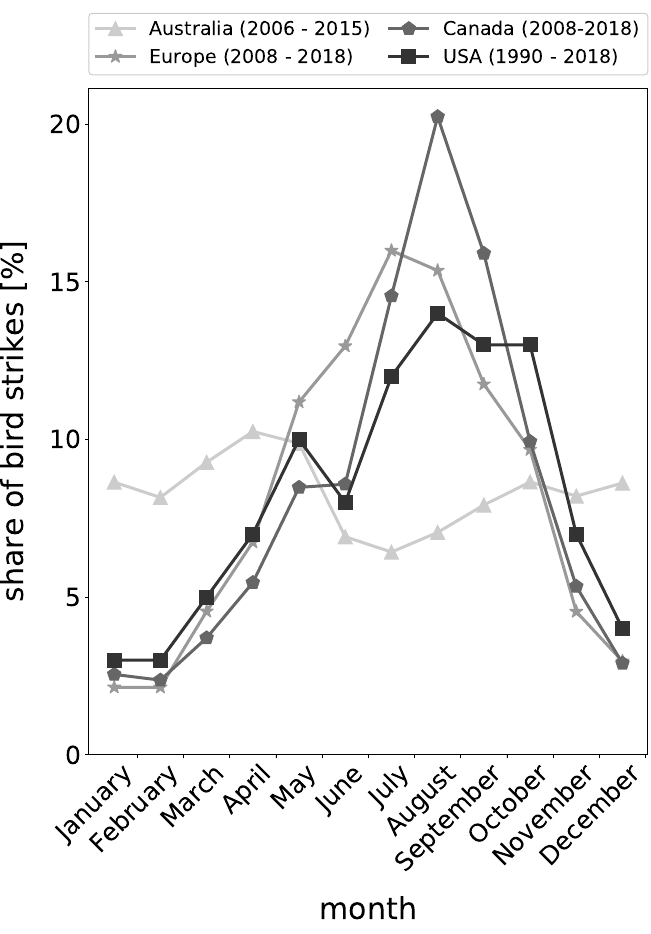
Figure 3. Seasonal distribution of bird strikes for Australia, Europe, Canada and the USA